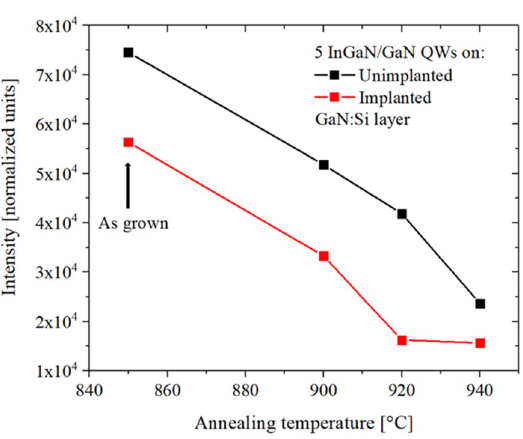
Figure 14. Intensity of the PL spectra of the MQW structure grown on unimplanted (black line) and implanted GaN:Si (red line) as grown (850 °C) and after annealing (900 °C, 920 °C, 940 °C). PL intensity was normalized to exposure time 100